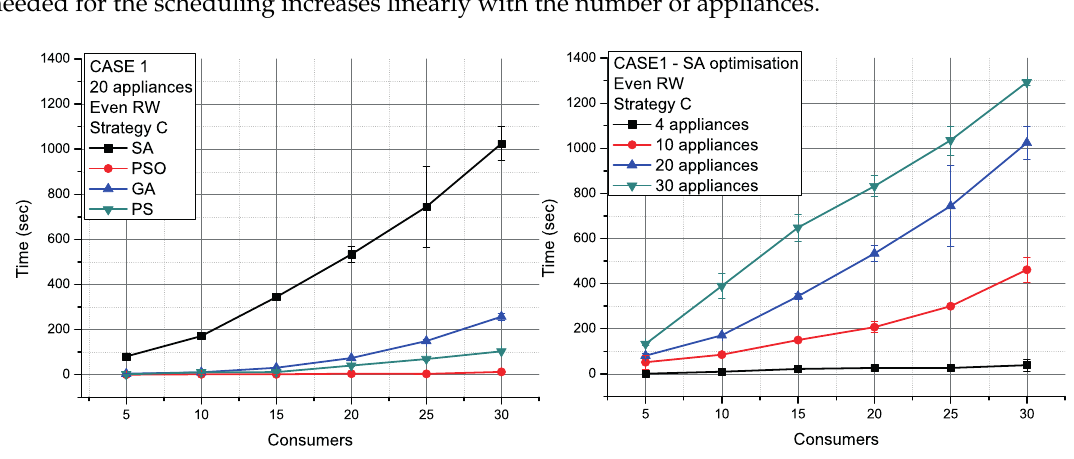
Figure 10. Different approaches ( left ) and appliances number results ( right ).